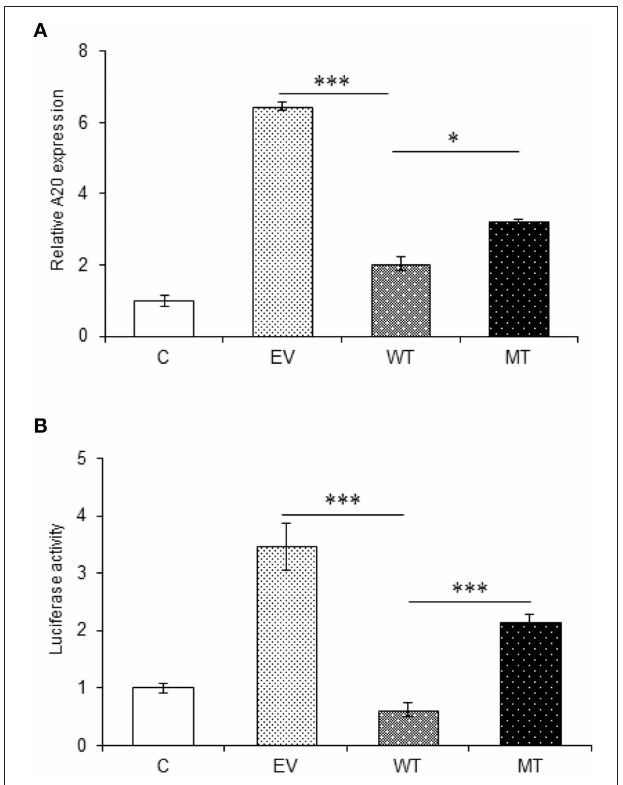
FIGURE 6 | A20 expression in the presence of miR-125b. A20 exhibited decreased expression in the presence of miR-125b (A) miR-125b and A20 were co-transfected in HT29 cells for 48h. After 48h, RNA was isolated and reverse transcribed to investigate the mRNA expression of A20 through qRT-PCR. GAPDH gene was used as an internal reference. (B) miR-125b and A20 were co-transfected in HT29 cells along with pRL-TK control plasmid for 24h. After 24h, the dual luciferase reporter assay was performed to evaluate the luciferase activity corresponding to A20 expression. * Denotes level of significance. * p ≤ 0.05, *** p ≤ 0.001. C, untransfected control; EV, empty vector; WT, wild type; MT, mutant. Bars represent standard error of the mean (SEM).